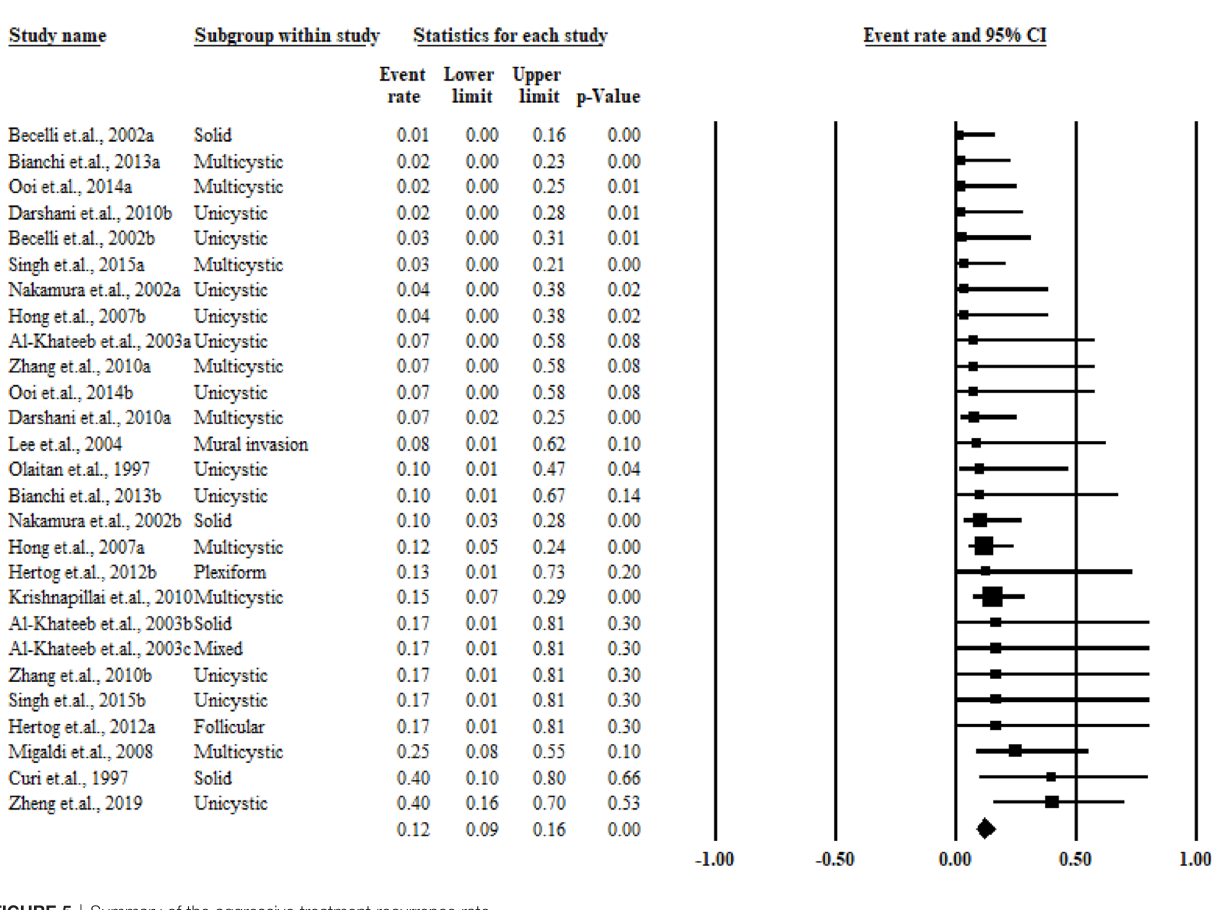
FIGURE 5 | Summary of the aggressive treatment recurrence rate.